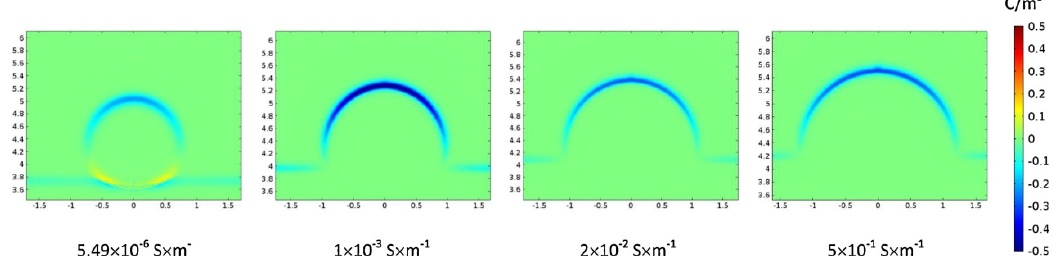
Figure 12. Changes in surface charge density of the droplet for different conductivity [62].